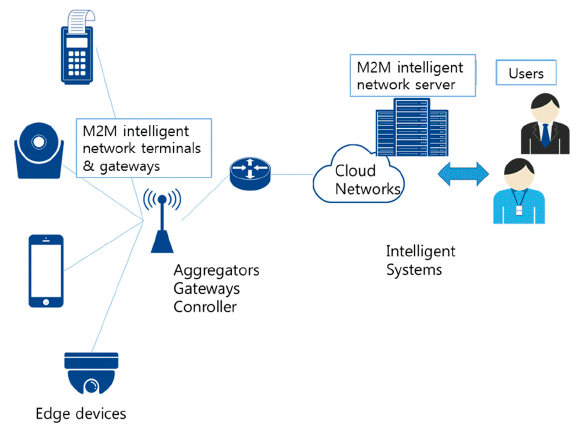
Figure 1. Configuration of the M2M intelligent network environment.